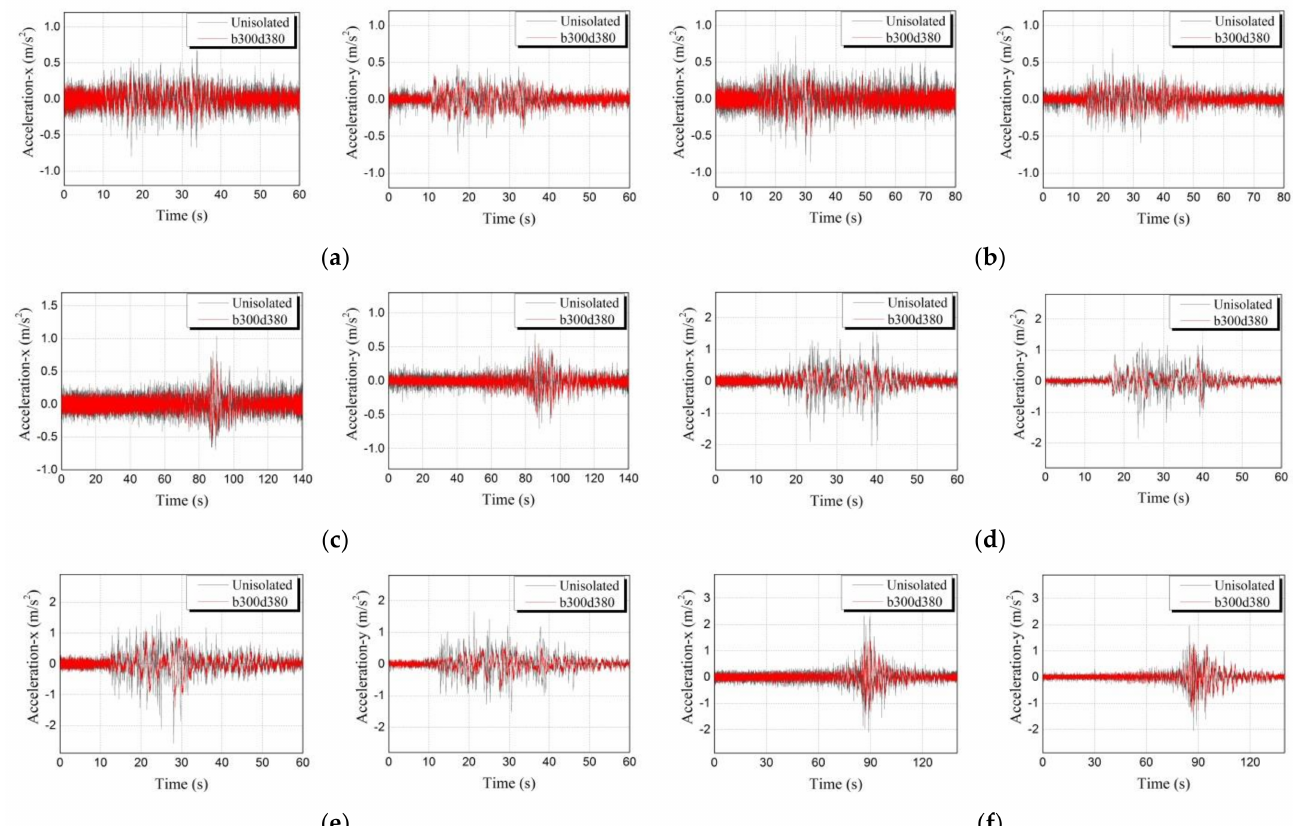
Figure 24. Acceleration comparisons between the equipment with b300d380 bearing and without iso- lation subjected to three low-frequency ground motions with ( a ) ChiChi-TCU049 of PGA = 0.7 m/s 2 ( b ) ChiChi-TCU122 of PGA = 0.7 m/s 2 ( c ) 061CHC of PGA = 0.7 m/s 2 ( d ) ChiChi-TCU049 of PGA = 2 m/s 2 ( e ) ChiChi-TCU122 of PGA = 2 m/s 2 and ( f ) 061CHC of PGA = 2 m/s 2